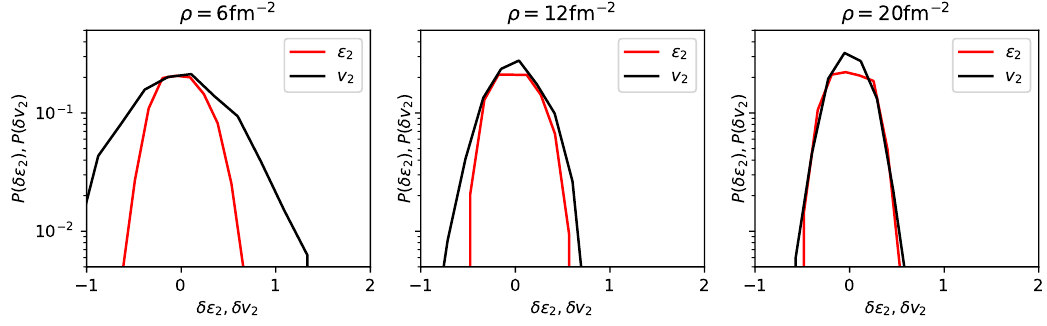
Figure 11 . Probability distributions of (cid:15) 2 and v 2 in the 20–30% centrality bin, for three different values of ρ